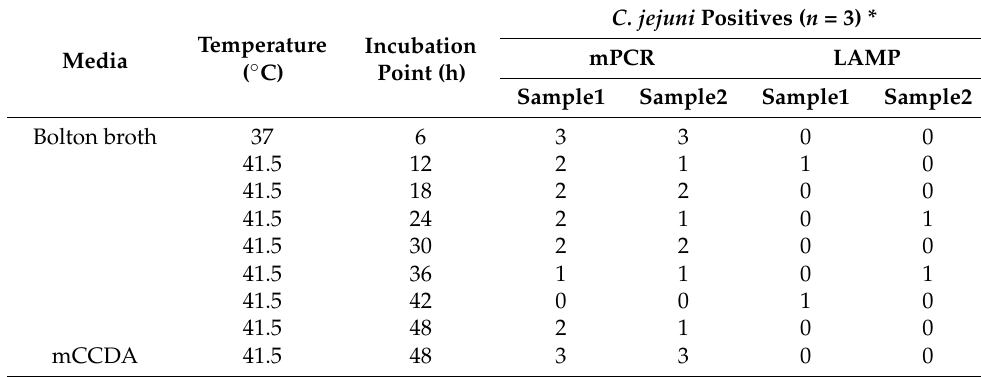
Table 8. Detection of C. jejuni in contaminated chicken